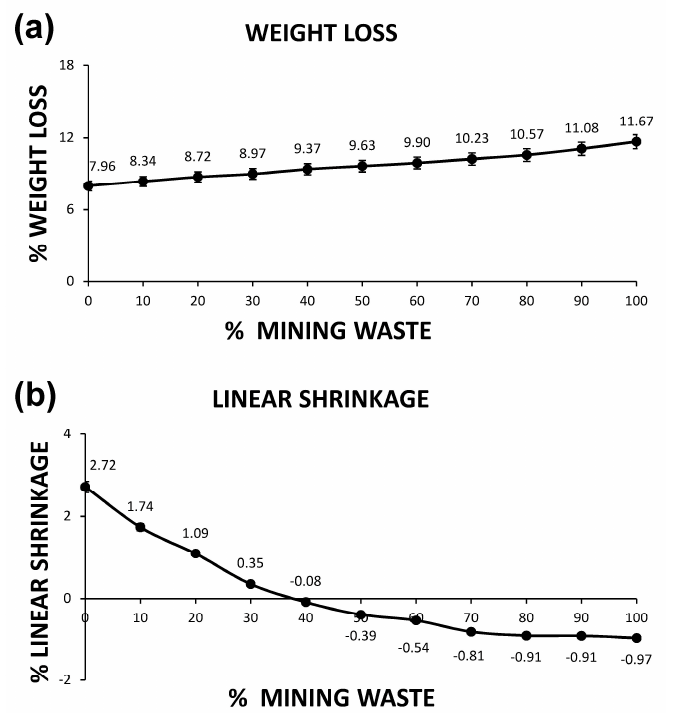
Figure 2. Physical properties of ceramic families with clay and mining waste after sintering ( a ) weight loss and ( b ) linear shrinkage. The weight loss of the different families of ceramic samples reflects a linear behaviour that increases as the percentage of mining waste increases. This is logical since it can be seen that the 0M10C family, composed only of clay, and the 10M0C family, composed only of mining waste, have similar weight losses to those obtained in the loss on ignition test for both materials - this coincidence derives that the temperature of this test and the sintering temperature are similar. Therefore, a linear increase in the percentage of mining waste leads to a linear increase in the loss of weight up to the maximum value. In short, the graph shows how the loss of weight between samples is quite similar, being greater the higher the percentage of mining waste. This fact will significantly affect the structure of the conformed ceramic with a higher percentage of mining residue, reflecting a higher percentage of pores. In turn, the linear shrinkage of ceramic families decreases as the percentage of mining waste increases. A virtually zero linear shrinkage value is obtained for samples conformed with 40% mining residue and 60% clay. Higher values of mining residue in the samples cause to expand during the sintering process. This test, like the weight loss test, determines the subsequent physical and mechanical properties. A ceramic with a higher weight loss and a lower linear shrinkage after sintering produces a more open internal structure. This structure causes a lower density, a higher porosity and a lower resistance, however, these results must be studied and evaluated according to the limits established by the regulations.